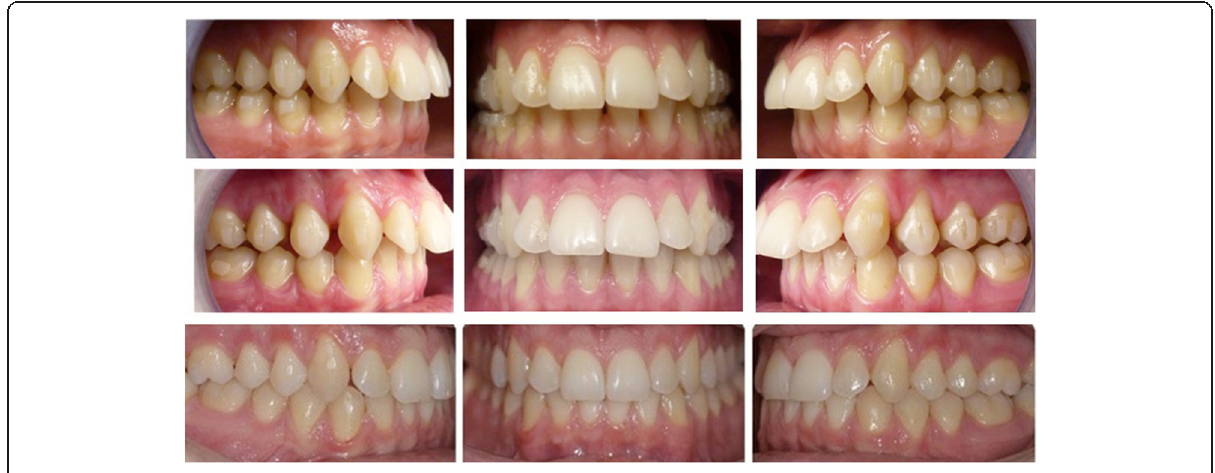
Fig. 6 Pre- and post-photos of one of the patients treated in this